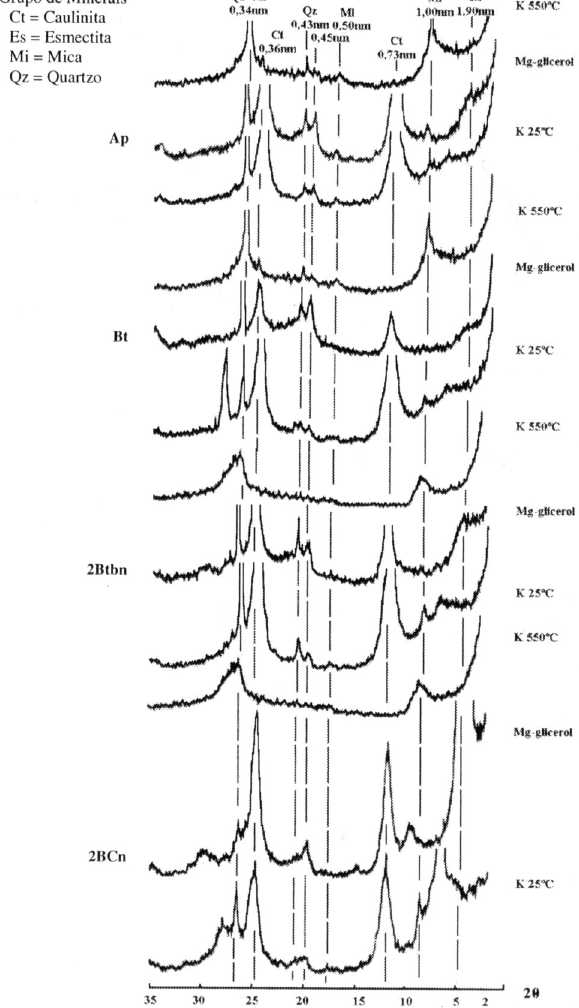
Figura 4. Difratogramas de raios X da fração argi- la do Perfil 2 - Argissolo Amarelo eutrófico planossólico solódico. Figura 3. Difratogramas de raios X da fração silte